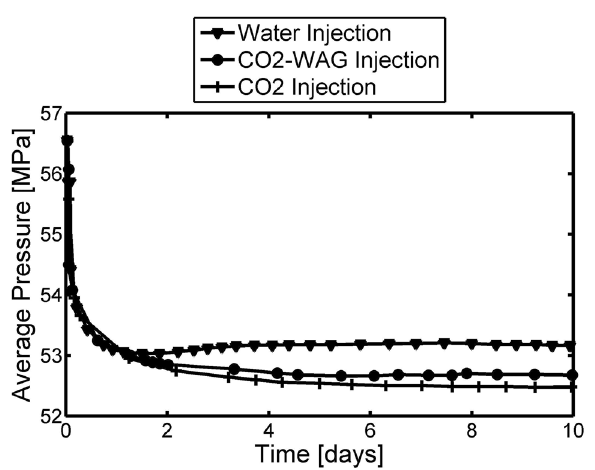
Fig. 15 Average pressure of the reservoir